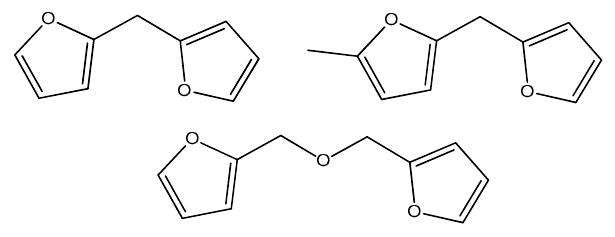
Figure 3. Observed dimers structures.